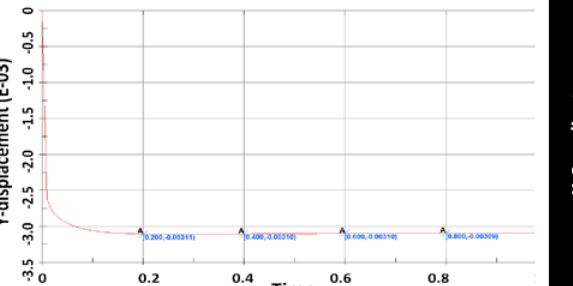
Figure 8: Vertical Y- Displacement of element no. 7202 after springback